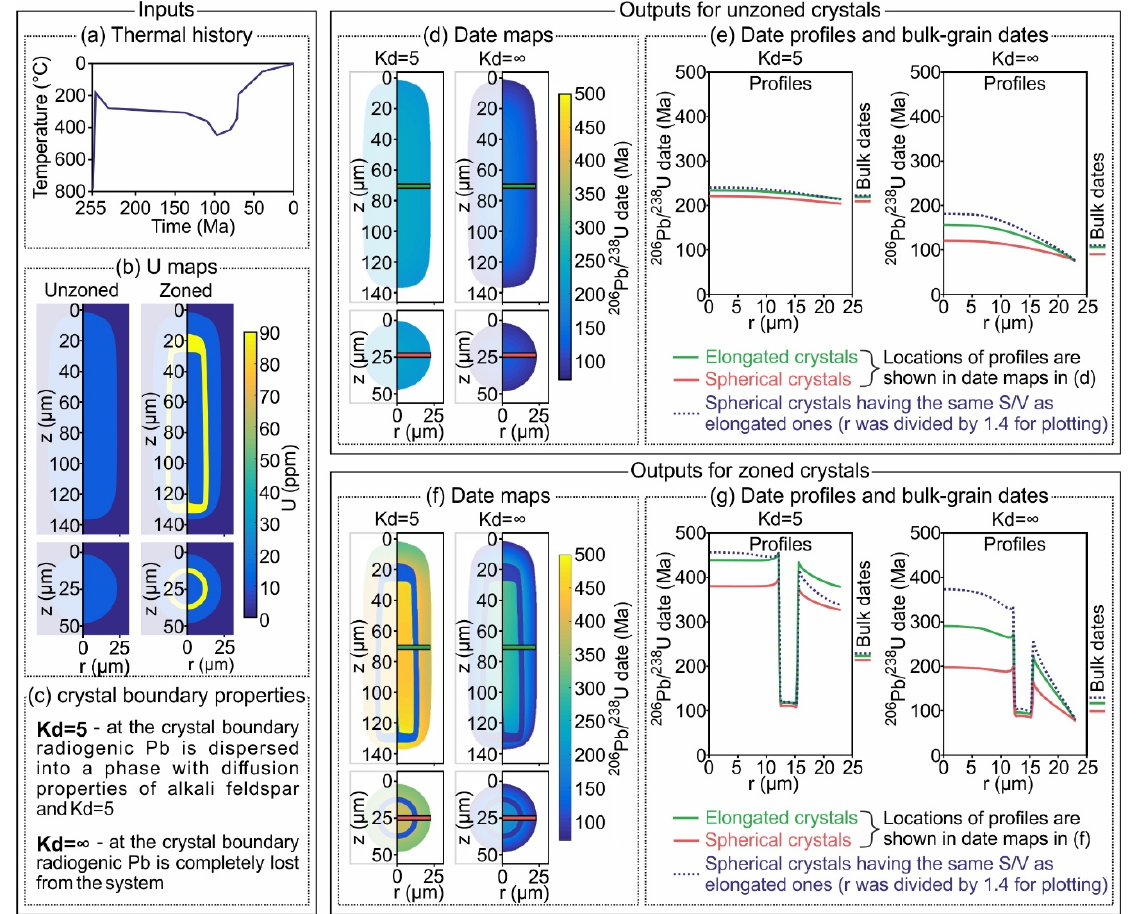
Figure 6. A comparison of bulk-grain and intra-grain 206 Pb/ 238 U dates of 12 apatite crystals that have different geometries, U zonation and degree of boundary openness but the same t-T path. ( a ) The modelled t-T path. ( b ) U concentration maps for elongated and r-normalised spherical crystals. U concentration maps for S/V-normalised spherical crystals are obtained by multiplying the r and z coordinates in those for r-normalised spherical crystals by 1.4. ( c ) Assumptions about radiogenic Pb behaviour at the apatite boundaries. ( d ) 206 Pb/ 238 U date maps for chemically homogeneous elongated and r-normalised spherical crystals. ( e ) Core to rim 206 Pb/ 238 U date profiles and bulk-grain 206 Pb/ 238 U dates for all of the chemically homogeneous crystals. ( f ) 206 Pb/ 238 U date maps for chemically zoned elongated and r-normalised spherical crystals. ( g ) Core to rim 206 Pb/ 238 U date profiles and bulk-grain 206 Pb/ 238 U dates for all of the chemically zoned crystals.